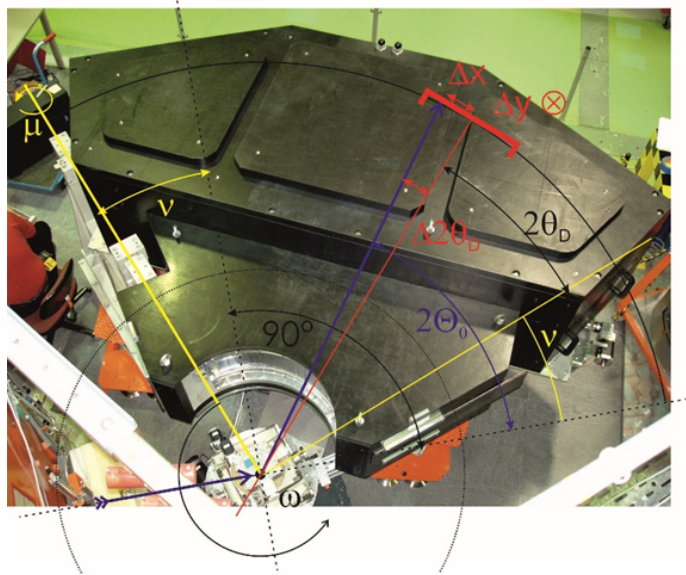
Figure 1: Flat-Cone Diffractometer E2, with the principle geometry axes. (© J.-U. Hoffmann, HZB)